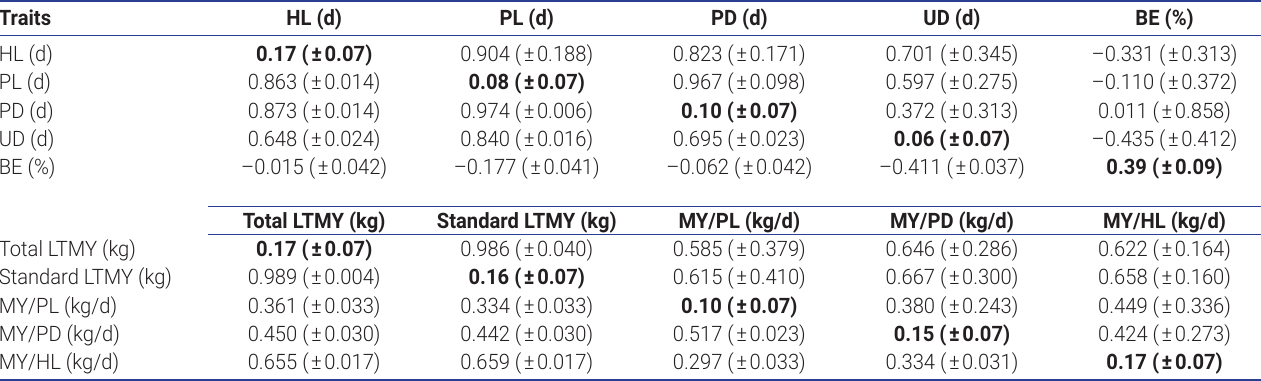
Table 2. Heritability (diagonal), genetic (above diagonal) and phenotypic (below diagonal) correlation among lifetime traits in Murrah